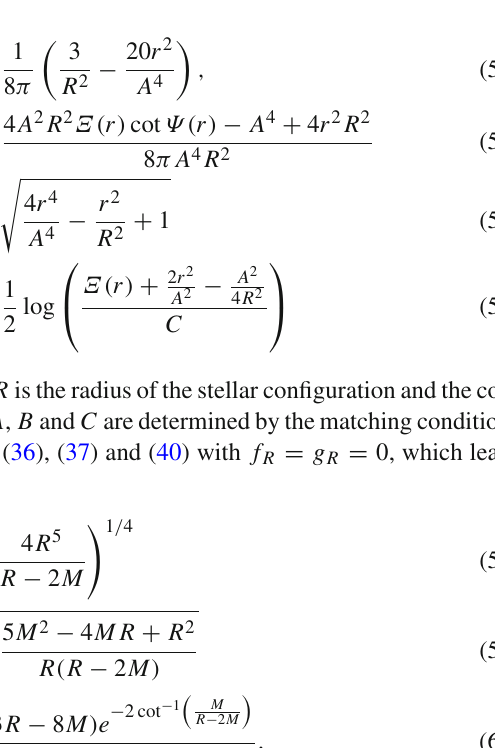
Fig. 6 [ g (cid:4) × 10 2 ] as a function of r for different values of K (left panel, n = 2) and for different values of n (right panel, K = 0 .